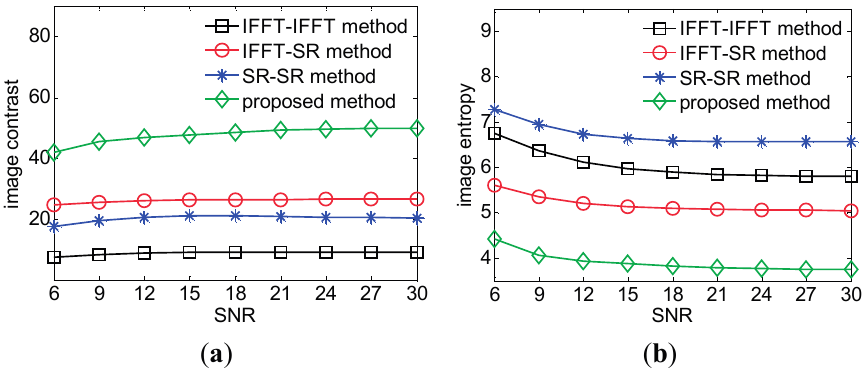
Figure 6. ( a ) Focusing performance of different methods: IC versus SNR; ( b ) Focusing performance of different methods: IE versus